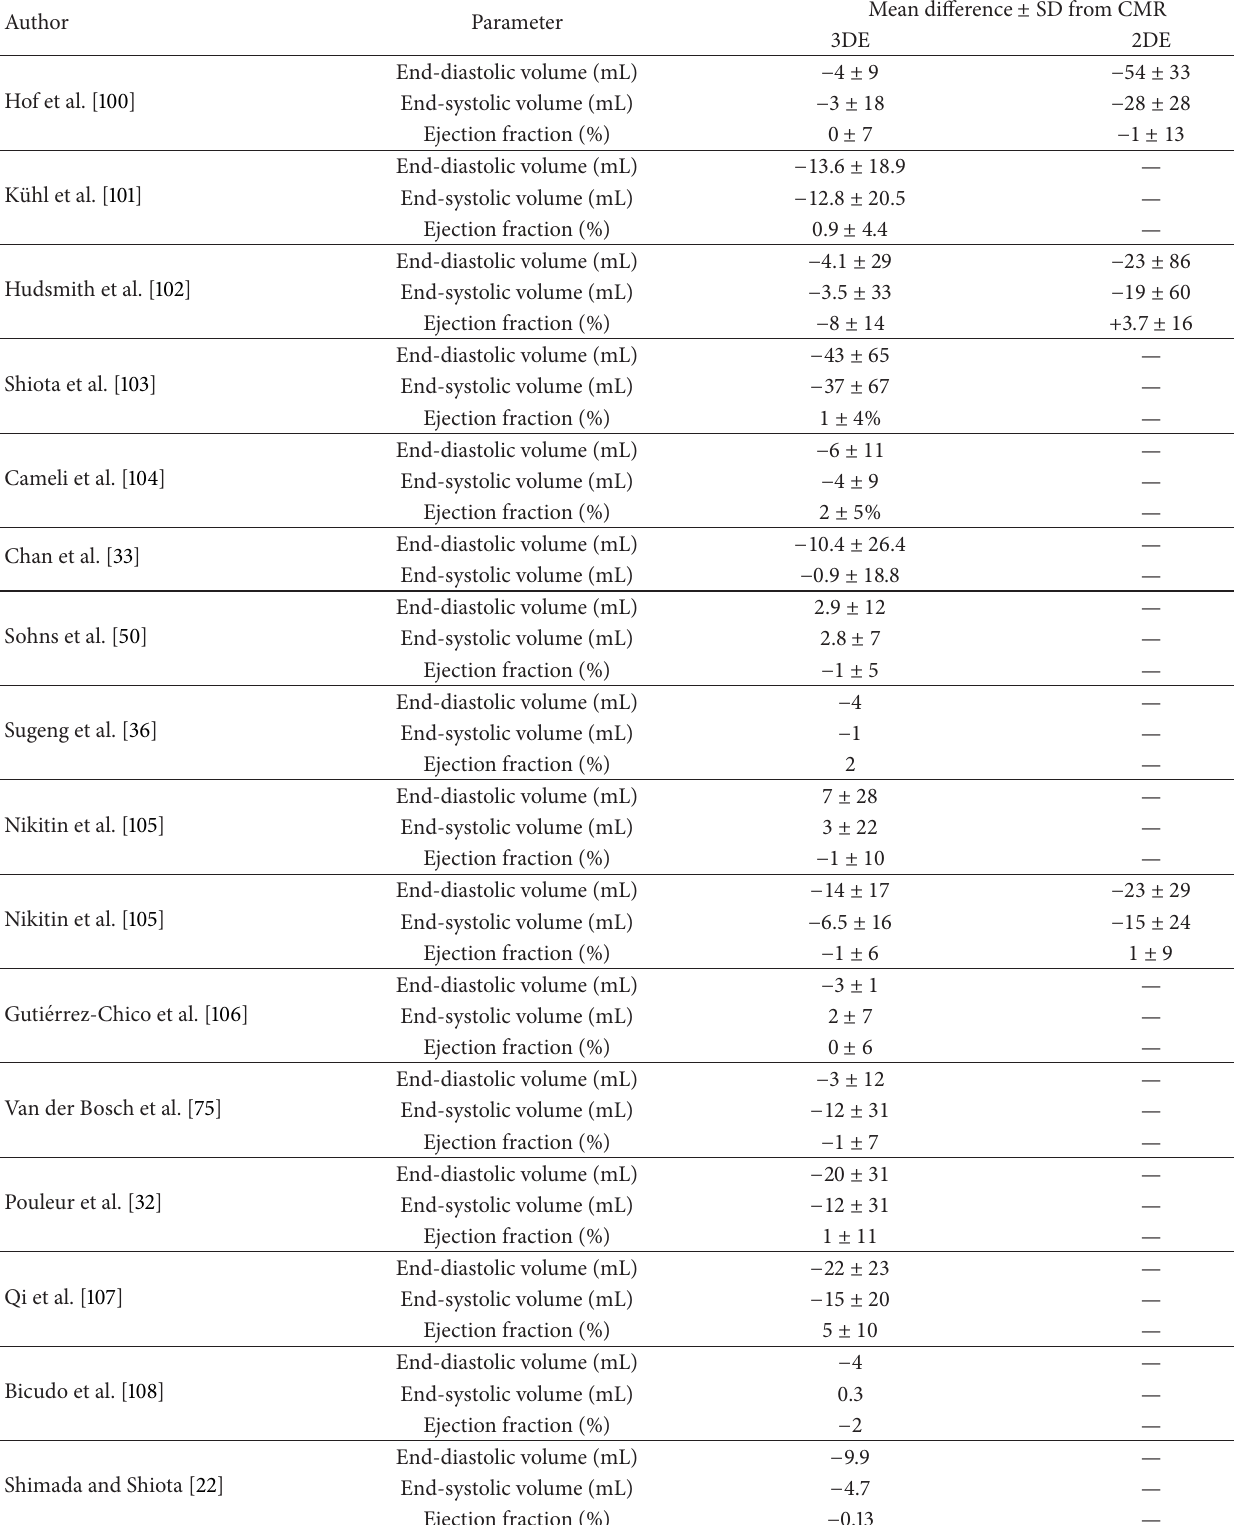
2DE: two-dimensional echocardiography; 3DE: three-dimensional echocardiography; CMR: cardiac magnetic resonance; SD: standard